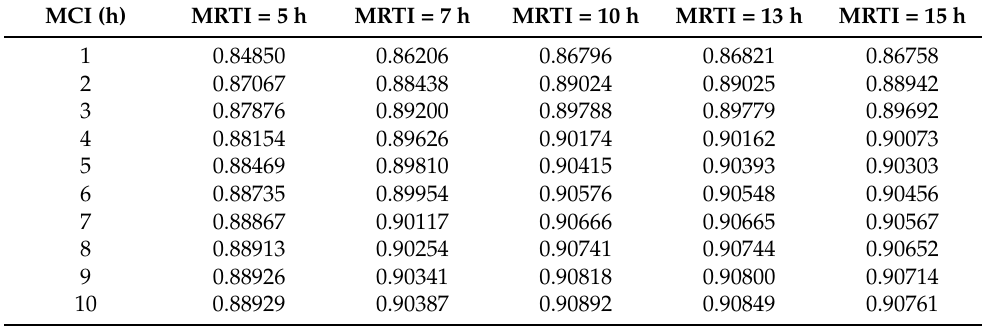
Table 7. Steady-state system availability (without human-error-related system failures).